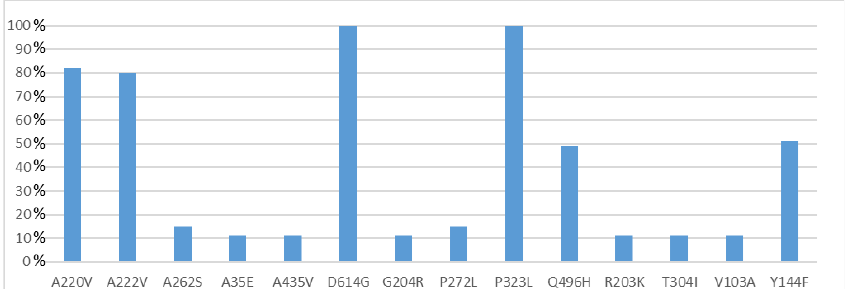
Figure 3. Frequency of amino acid mutations found in Sardinian samples (n = 55). Only mutations detected in more than 5% of samples were illustrated in this figure.